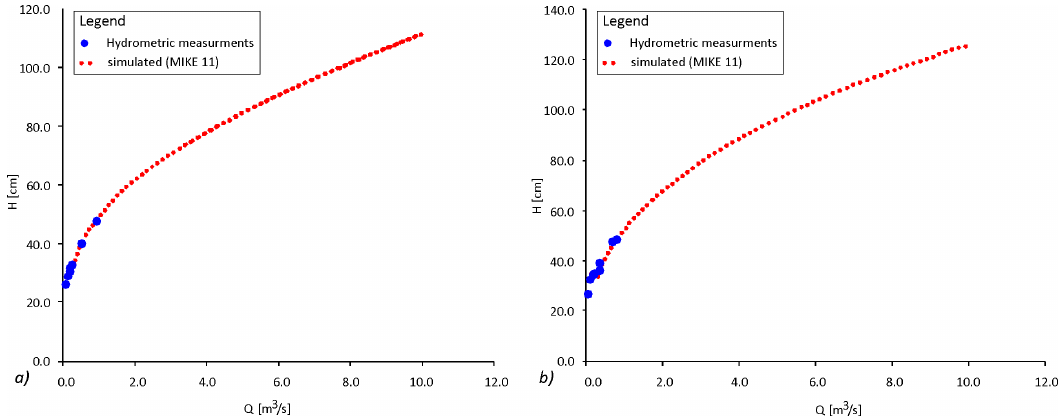
Figure 6. Rating curve for the water-level measurements of Javo ř í and Tmavý Brooks resulting from a fully dynamic one-dimensional (1D) hydrodynamic model (MIKE 11). ( a ) Javo ř í brook; ( b ) Tmavý brook.